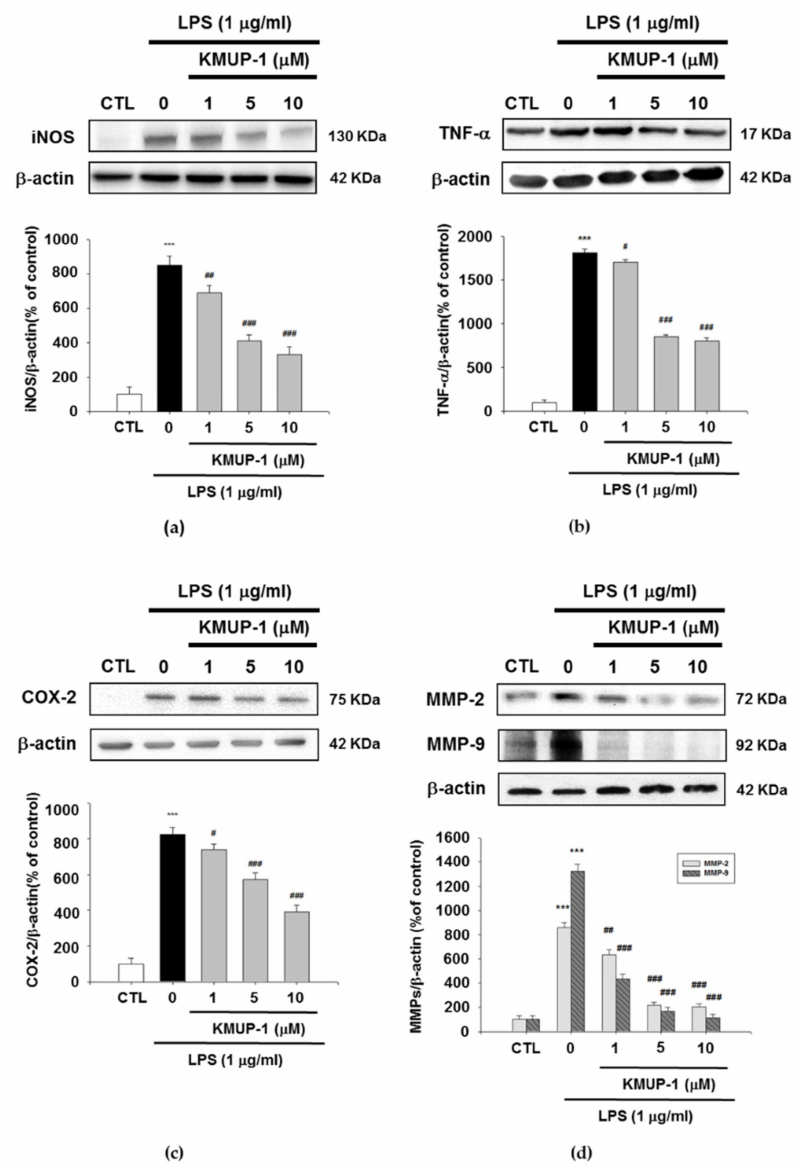
Figure 3. Effect of KMUP-1 on LPS-induced inflammatory reaction proteins expression in RAW 264.7 cells. ( a ) Inducible nitric oxide synthase (iNOS), ( b ) TNF- α , ( c ) cyclooxygenase-2 (COX-2), ( d ) MMP-2, and MMP-9 were detected by Western blot analysis. Values are presented as mean ± SEM, n = 3. *** p < 0.001 compared to control group. # p < 0.05, ## p < 0.01 and ### p < 0.001 compared to LPS